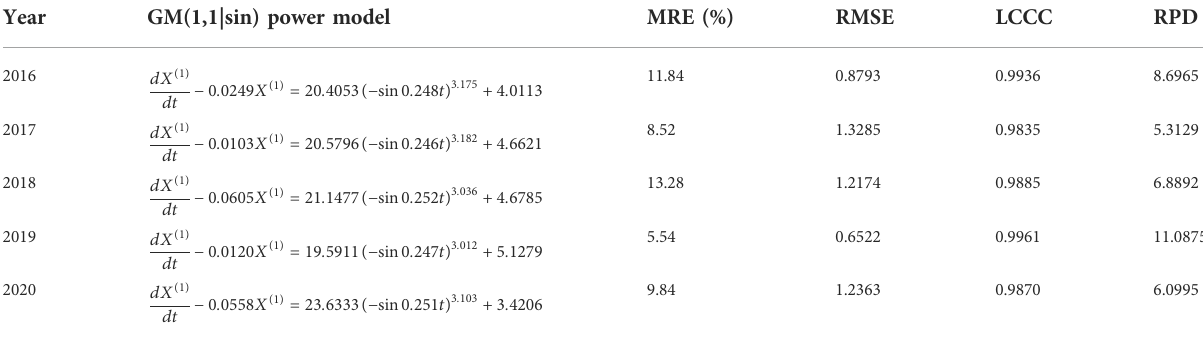
TABLE 8 Prediction models in 5